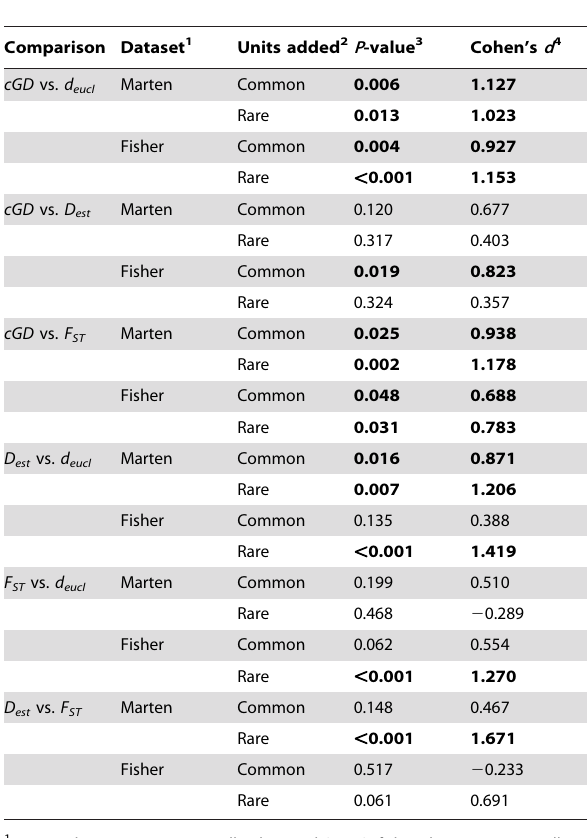
Table 3. The difference in mean absolute relative error (%) between genetic distance estimators for under-sampled sites.